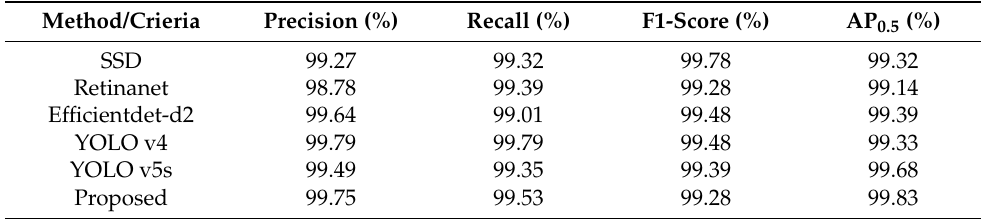
Table 4. Results on the non-smoke